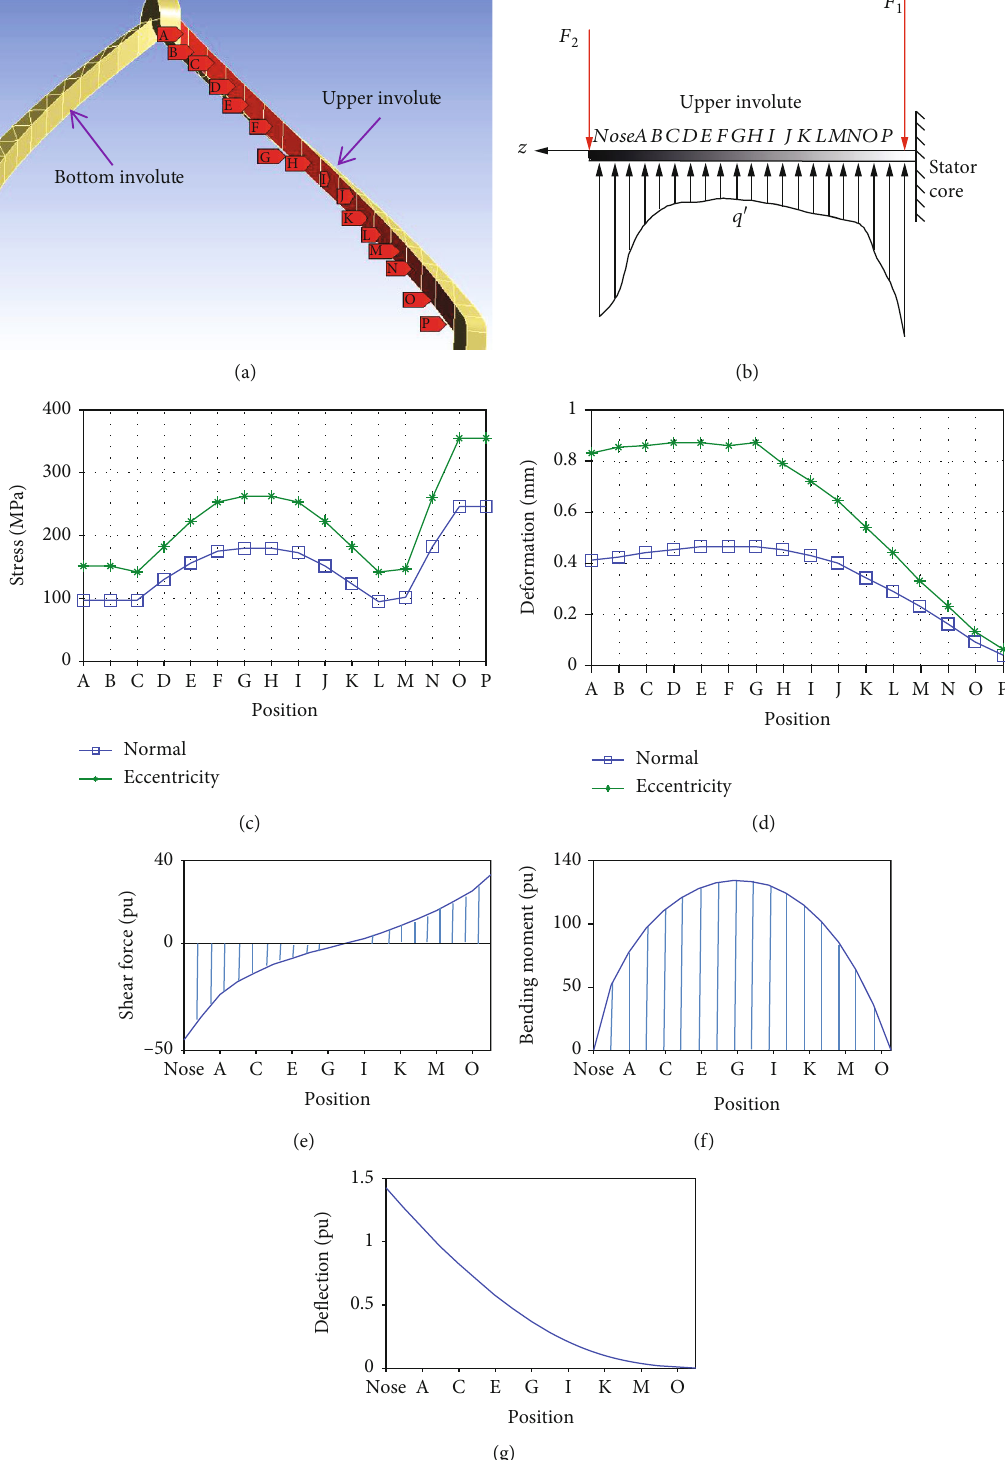
Figure 8: Coil 34 involute mechanical response: (a) probe position, (b) simpli fi ed model, (c) max stress, (d) max deformation, and (e – g) shear force, bending moment, and de fl ection,